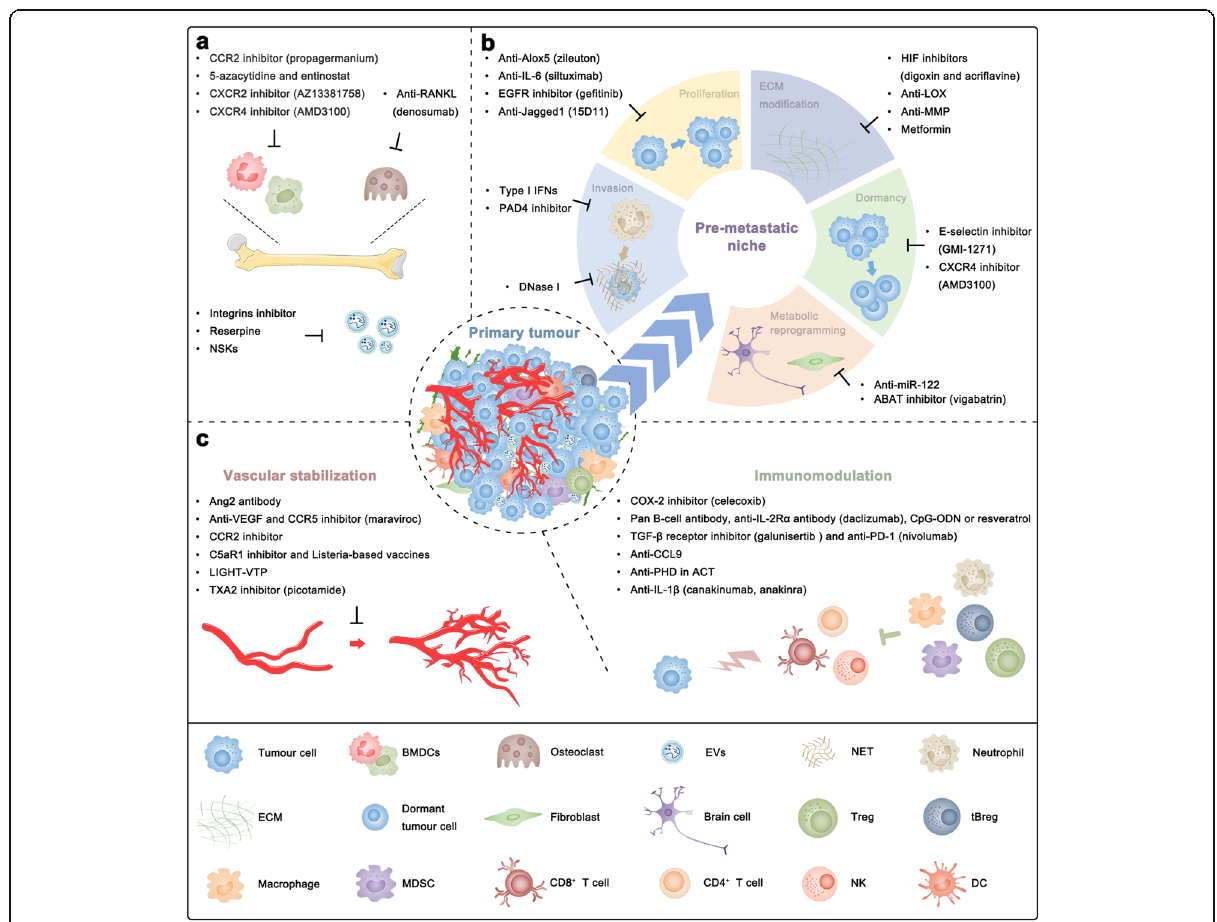
Fig. 3 Therapeutic opportunities targeting the pre-metastatic niche (PMN). a Targeting extracellular vesicles (EVs) and bone marrow prevents PMN formation. b Targeting the interactions between tumour cell and PMN by which tumour cells acquire the ability to successfully develop into metastasis lesions at metastasis sites averts tumour metastasis progression. c Targeting vascular destabilization and immunosuppression deconstructs the complexity of the